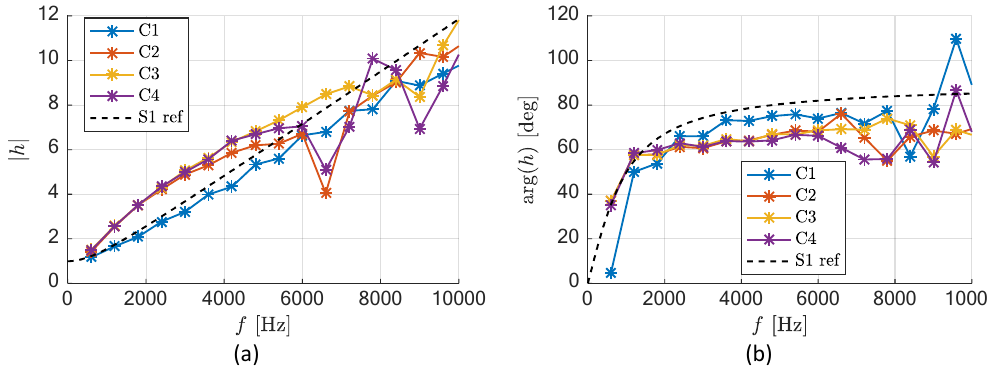
Figure 29: Numerical results of the transfer function for the reference gear pump under four design configurations (from C1 to C4) at 2000 RPM and 100 bar (a) magnitude (b) phase.